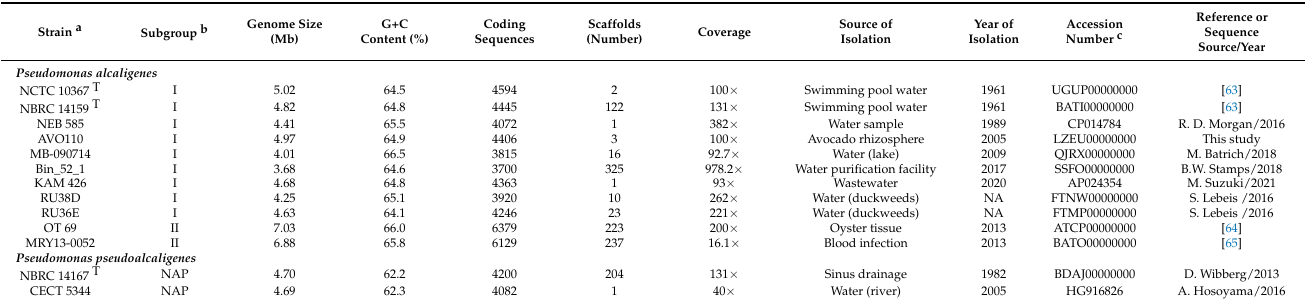
Table 2. General genome features of Pseudomonas strains analyzed in this work.